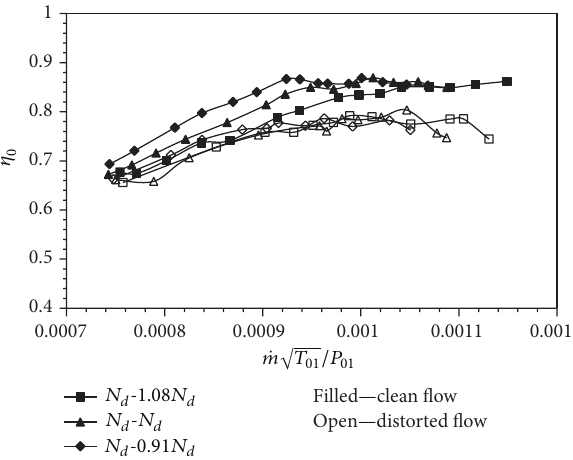
Figure 11: Variation of overall efficiency under clean and tip-strong radial inflow distortion.